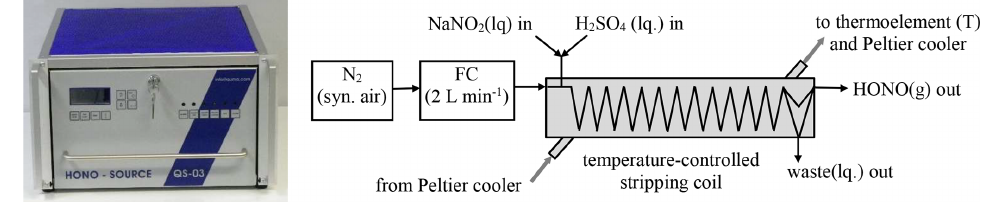
Figure 1. Picture of the HONO source (QUMA) and its experimental